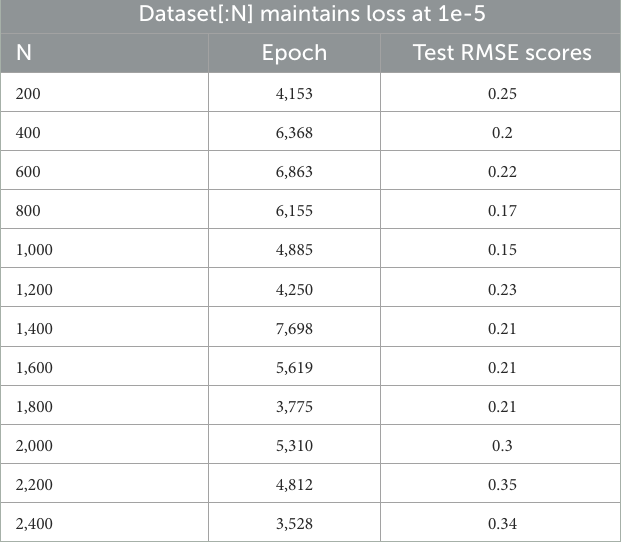
TABLE 3 Test score RMSE and epoch for